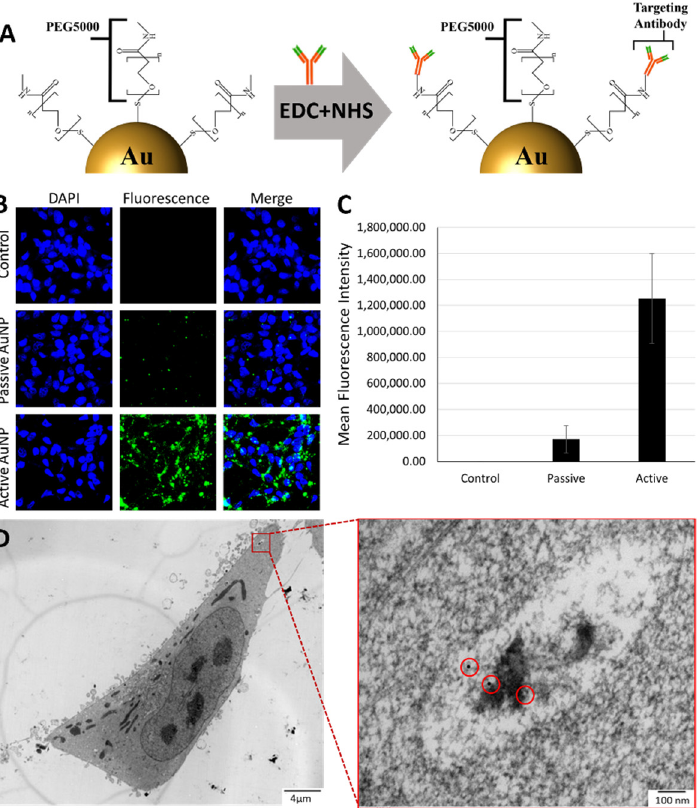
Figure 4. ( A ) Schematic structure of PSMA targeted AuNP. ( B ) Fluorescence imaging showing AuNP targeting and uptake. ( C ) Quantitative analysis of fluorescence microscopy images via fluo- rescence counts. ( D ) Transmission electron microscope (TEM) images of LNCaP cancer cells treated with AuNPs.